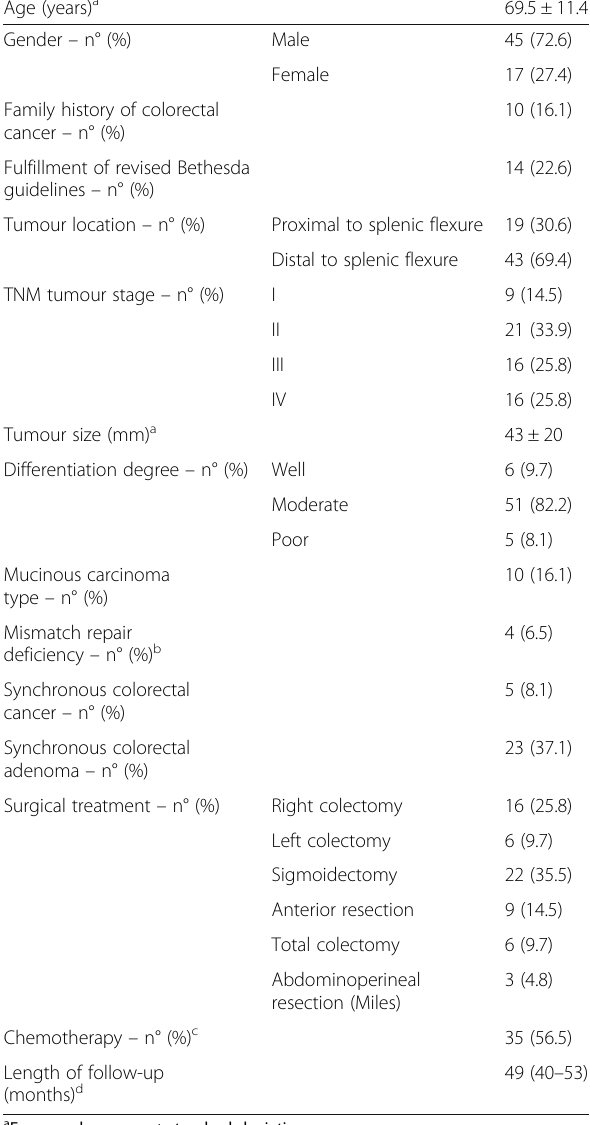
Table 1 Demographic, clinical and tumour-related characteris- tics of patients included in the study (n =